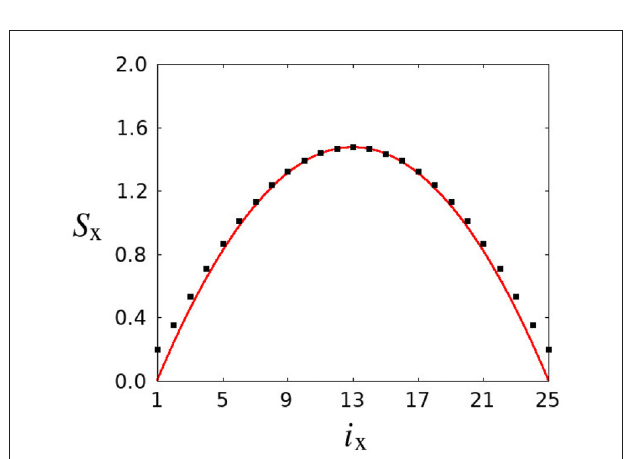
FIGURE A8 | A square prism beam, with sides L = 25 and height H = 101, subject to shear ( X ), torsion ( W ) and biaxial bending ( U and V ).